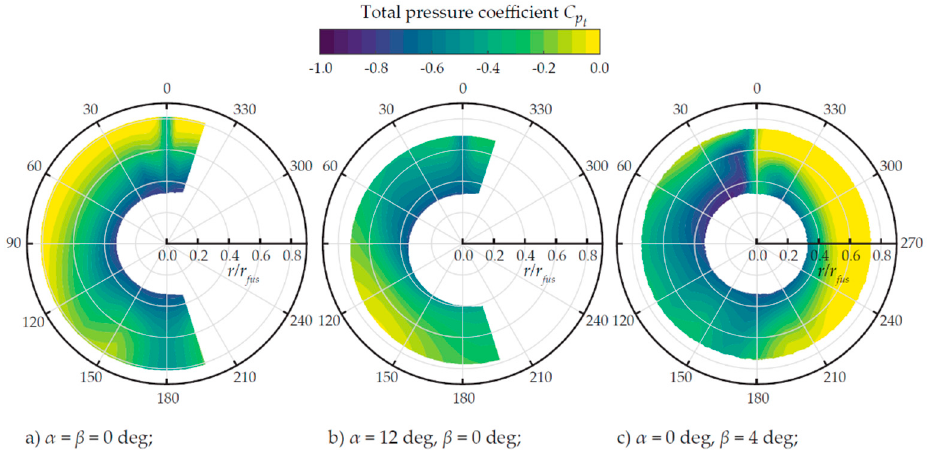
Figure 16. Total pressure field upstream of the FF air intake ( x / L fus = 0.89) in cruise and off-design conditions. Measurements taken on the 3D PFC setup at V 0 = 40 m/s.